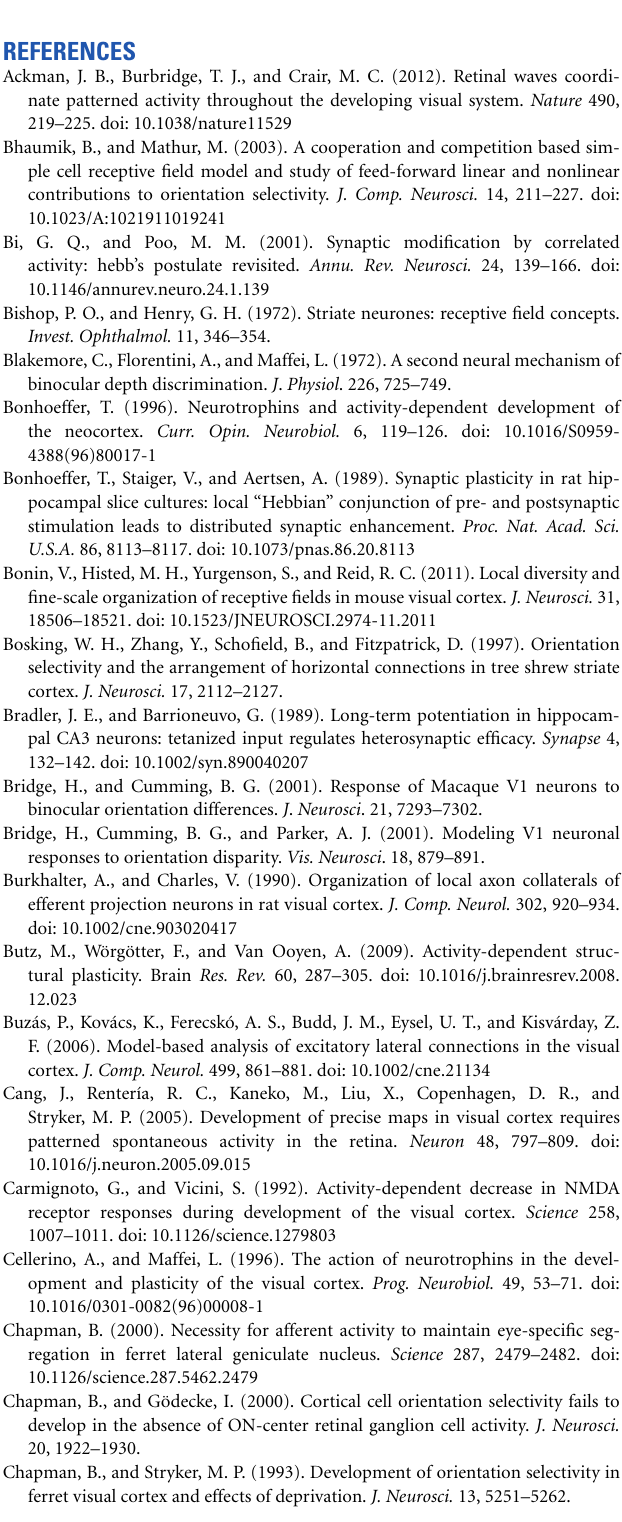
Table 1 | Distribution of IDPO with and without cortical near neighbor Figure 1S | (A) Synaptic weight development according to the LGN activity interaction. pattern when LGN cell at location J and its neighbors are active during weight update. (B) Synaptic weight development when LGN layer is DL = 0.0125 and DL = 0.0125 activated by spontaneous activity DC = 0.0075 and DC = 0 Range of |IDPO| % of OR % of OR selective cells selective cells 0 ◦ ≤ |IDPO| < 10 ◦ 39.165